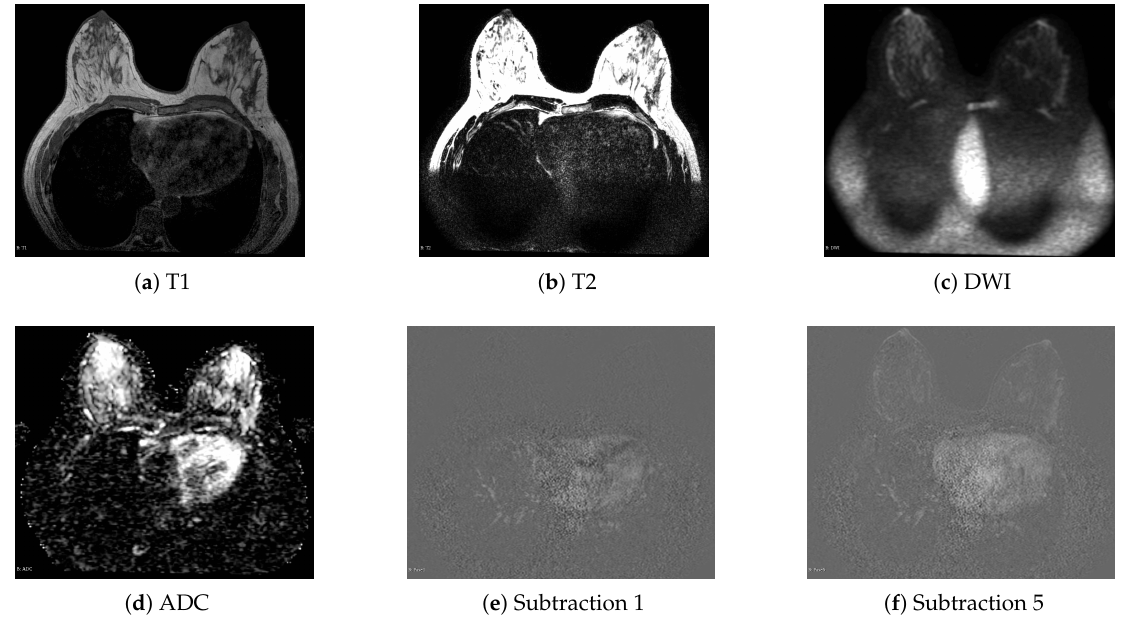
Figure 3. Visualization of the MRI sequences in the breast cancer